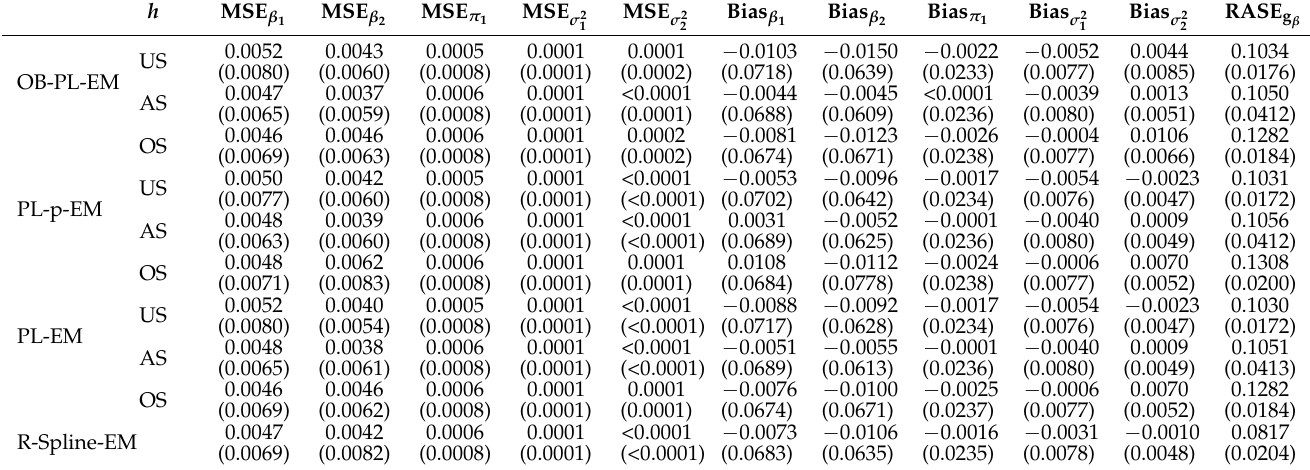
Table 3. Averages (and standard deviations) of the performance measures for n = 400.